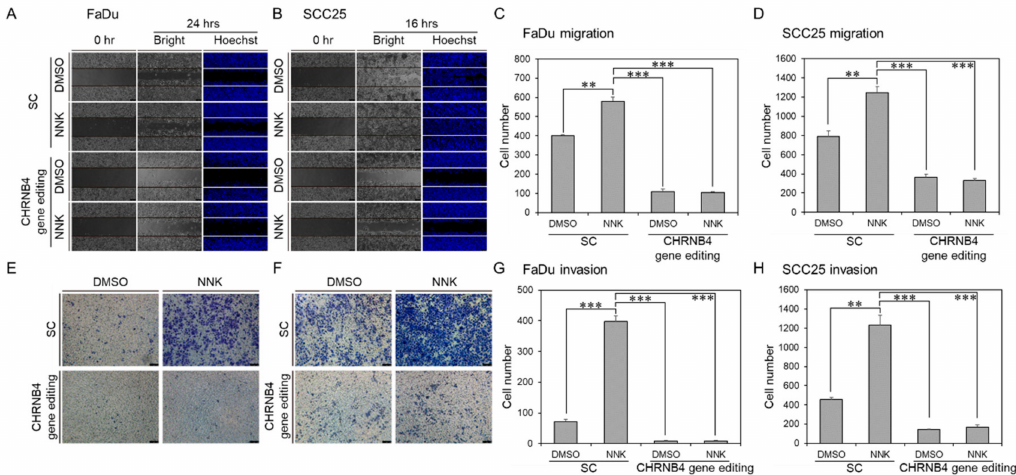
Figure 7. Migration and invasion e ff ects in parental and NNK-treated HNSCC cell lines with CHRNB4 gene editing. The migration and invasion assays of long-term NNK-treated ( A , E ) FaDu and ( B , F ) SCC25 cell lines with or without 0.1 µ M NNK treatments were conducted and recorded. The migration and invasion of ( C , G ) FaDu and ( D , H ) SCC25 cell lines were counted and presented in a histogram. The experiments were repeated three times, and a two-sided p -value was calculated with Student’s t -test. The error bars indicate the standard error. p -values less than 0.01, and 0.001 are denoted by **, and ***,